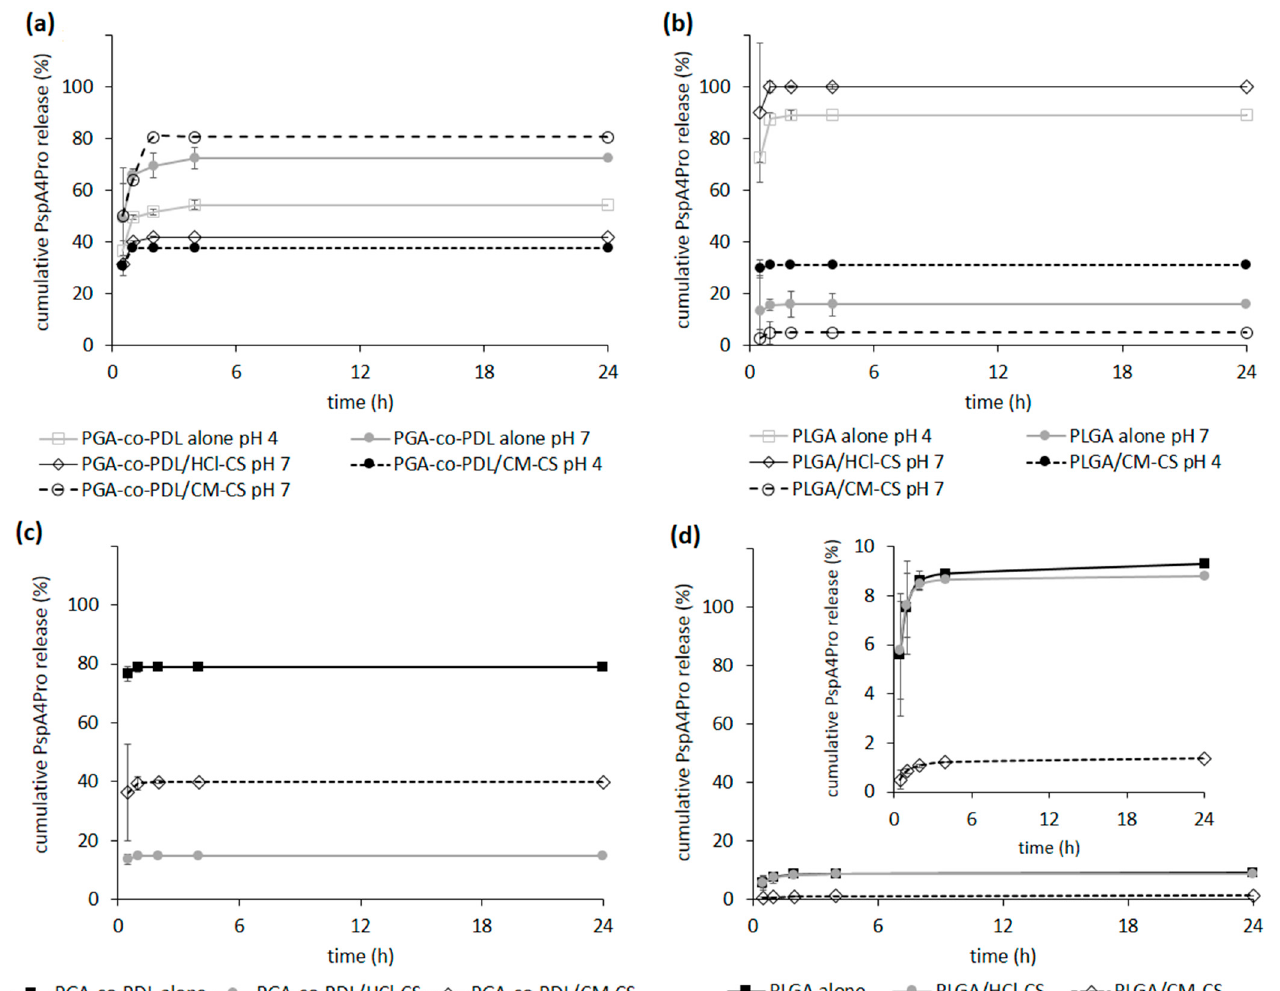
Figure 3. In vitro release of pneumococcal surface protein A (PspA4Pro) from NPs in phosphate buffered saline, pH 7.4. ( a ) PGA-co-PDL and ( b ) PLGA NPs carrying surface-adsorbed PspA4Pro at pH 4 or 7 prepared by o / w single emulsion. ( c ) PGA-co-PDL and ( d ) PLGA NPs prepared at pH 7.0 by w / o / w double emulsion with encapsulated PspA4Pro. The inset in ( d ) shows the same data in another Y-axis scale. Hybrid NPs were prepared with carboxymethyl chitosan (CM-CS) and with chitosan hydrochloride (HCl-CS). Data represent mean ± SD, n = 3.